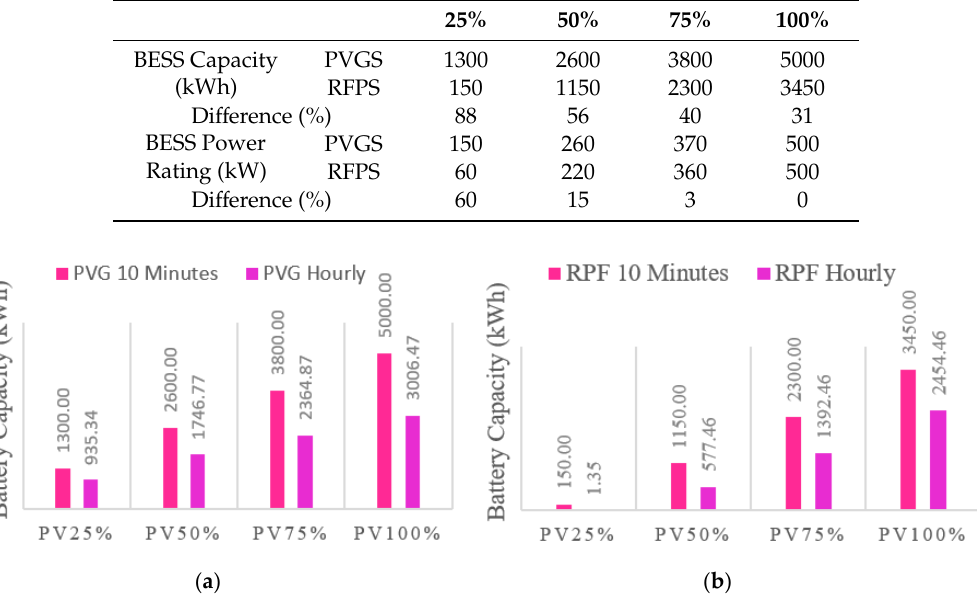
( b ) Figure 15. Maximum demand reduction in kW for both scenarios: ( a ) PVGS and ( b ) RFPS. The other important factor for designing BESS is the consideration of autonomy days (AD) to cope with the weather uncertainty. Figure 16 shows the BESS failures (blue line) due to inadequate BESS capacity. Discharging the BESS below its allowable limit is detrimental to its technical lifespan. Therefore, increasing the AD would address this problem satisfactorily. In this regard, this paper proposes optimum AD utilization to size the BESS. Figure 17 shows a similar case study as the one in Figure 16, but with increased AD from 20% to 40%. This helps the BESS to prevent sudden charging and stop discharging defects (spikes). In this case, by adjusting the AD to 40%, the capacity of the BESS increased from 3.45 to 4 MWh. The BESS power rating still remains the same at 500 kW. The